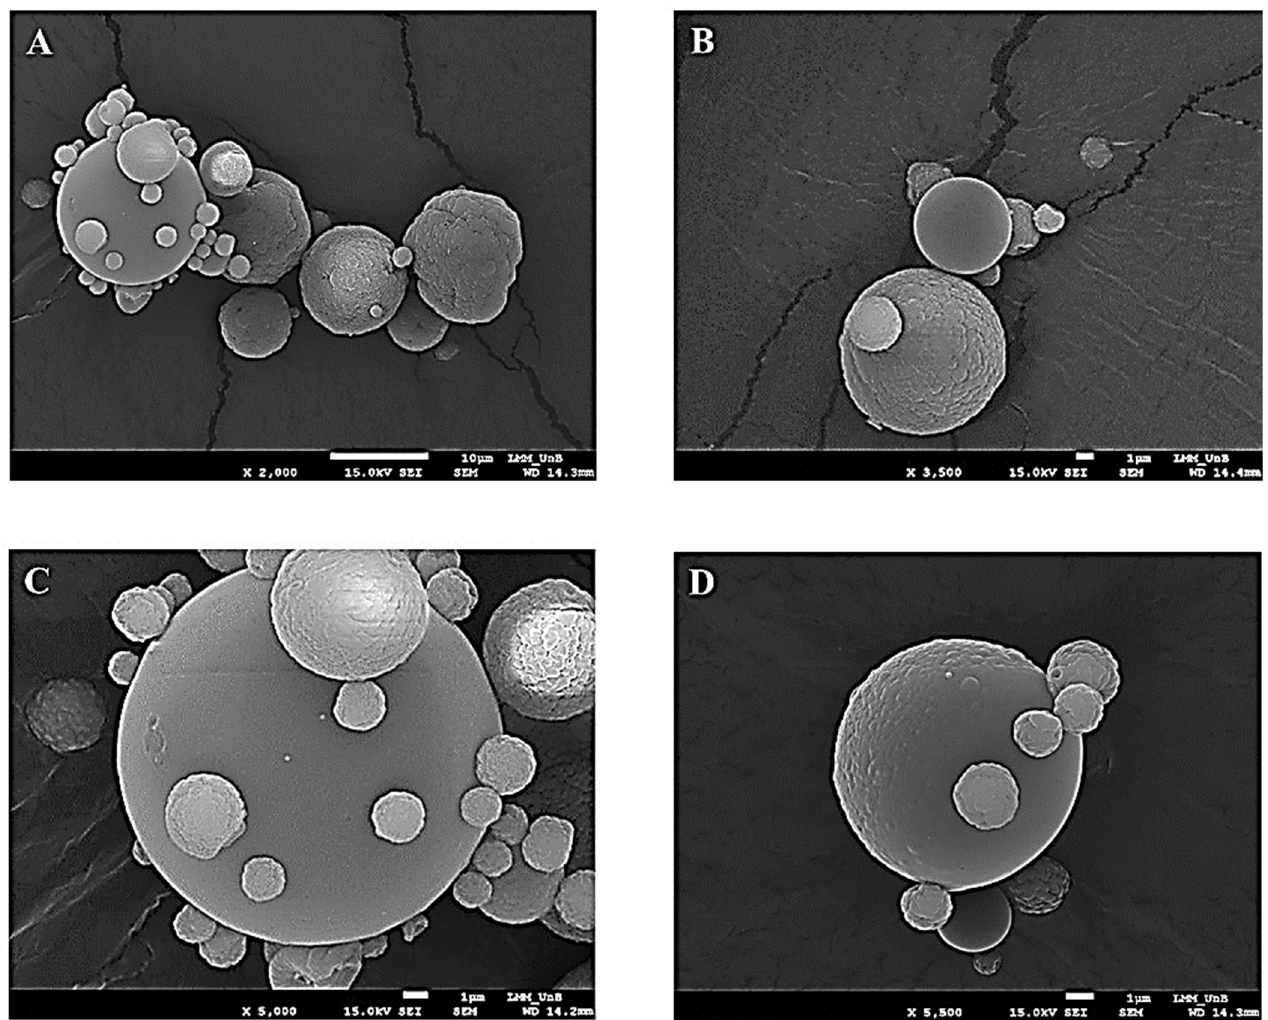
Figure 1. Photomicrograph obtained by scanning electron microscopy at magnifications of 2000 times ( A ), 3500 times ( B ), 5000 times ( C ) and 5500 times ( D ) for taperebá peel microparticles (TMPs) obtained by spray drying using chitosan as an encapsulating agent.